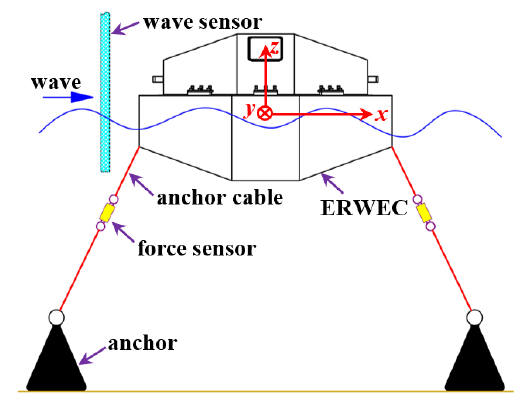
Figure 2. Mooring method.